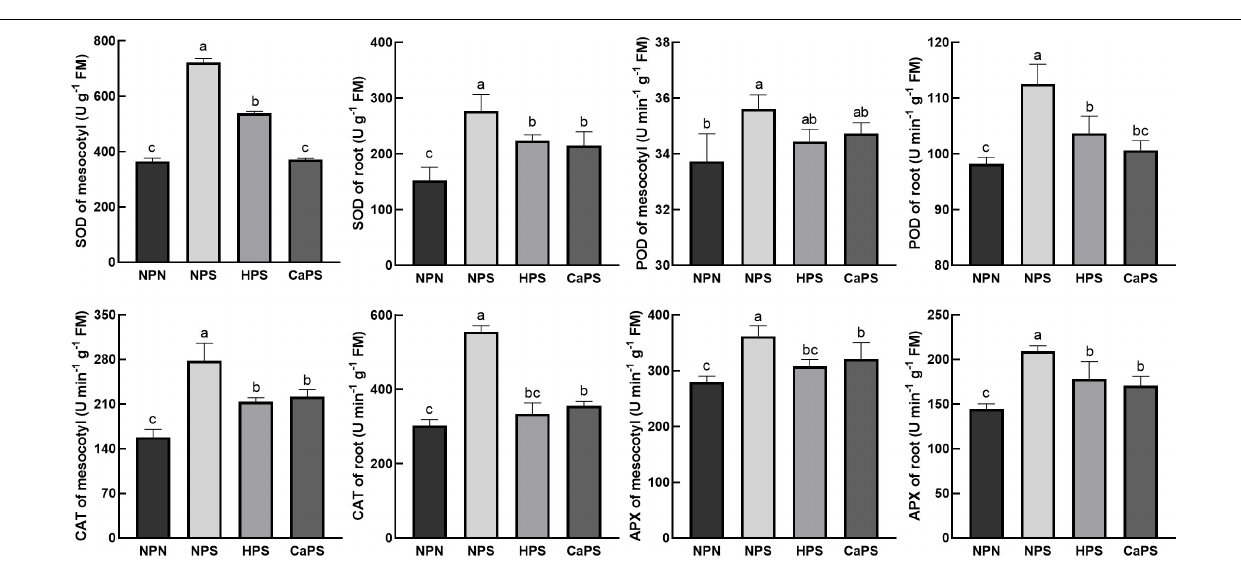
expression of these genes ( Figure 9 ). Compared with NPS, the expression levels were reduced by 25.74, 20.86, 63.53,